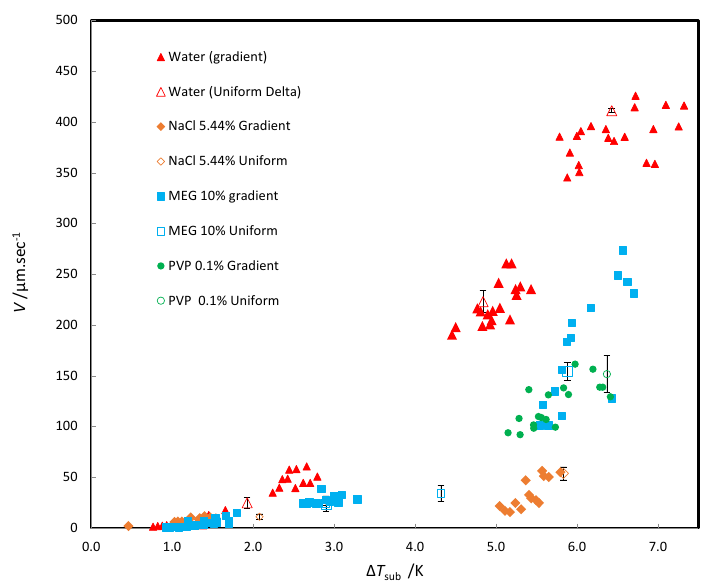
Figure 16. Film velocity as a function of supercooling for methane hydrate formed on quiescent water droplets with and without inhibitors. Data for hydrates formed under uniform constant temperature and a constant temperature gradient are shown. Error bars correspond to one standard uncertainty.